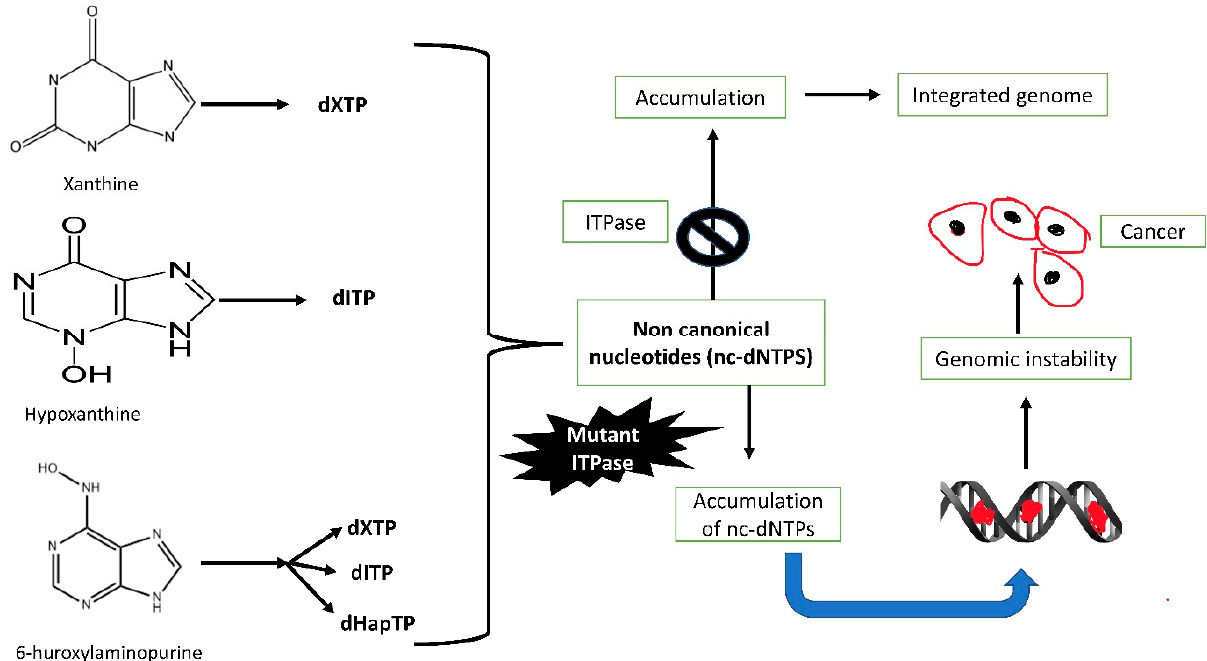
Figure 5. Role of ITPase in genomic stability and cancer.